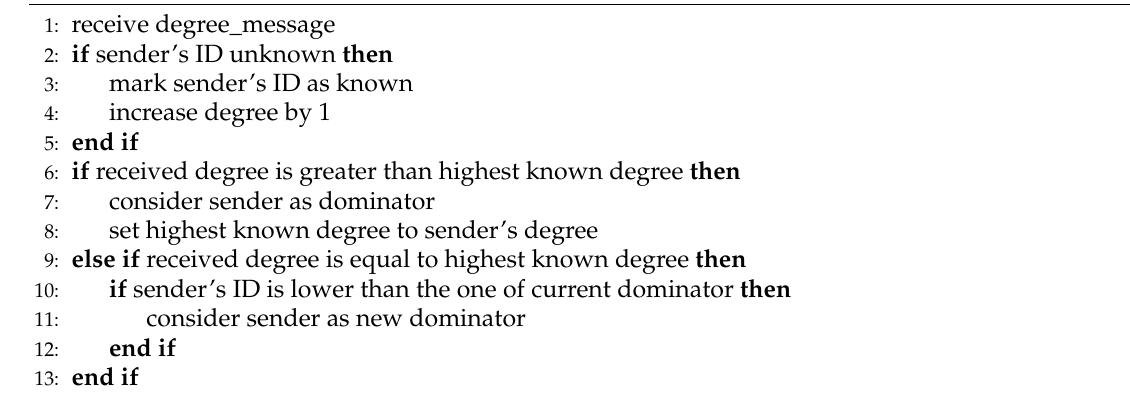
Algorithm 3 Neighbor discovery and degree